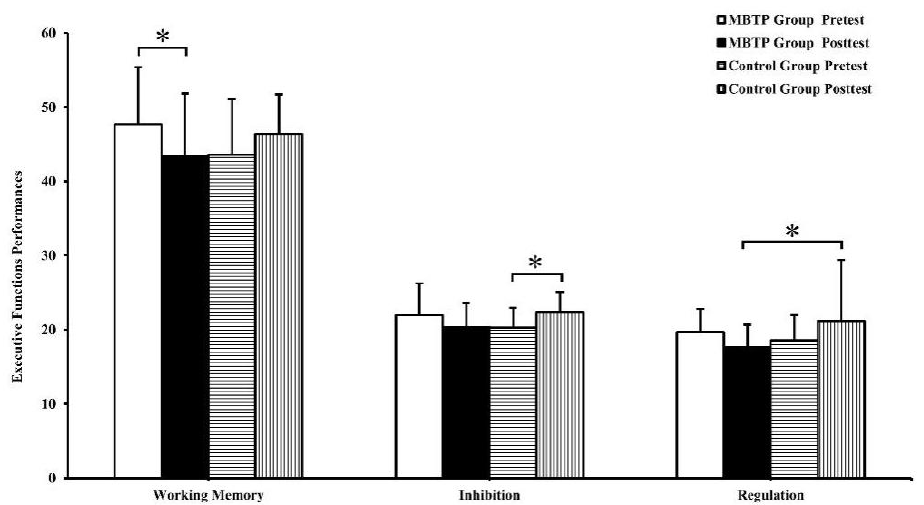
Figure 2. Performances for executive functions (mean and standard deviation) of time point (baseline versus post-test) and group (MBTP versus Control), * p < 0.05.